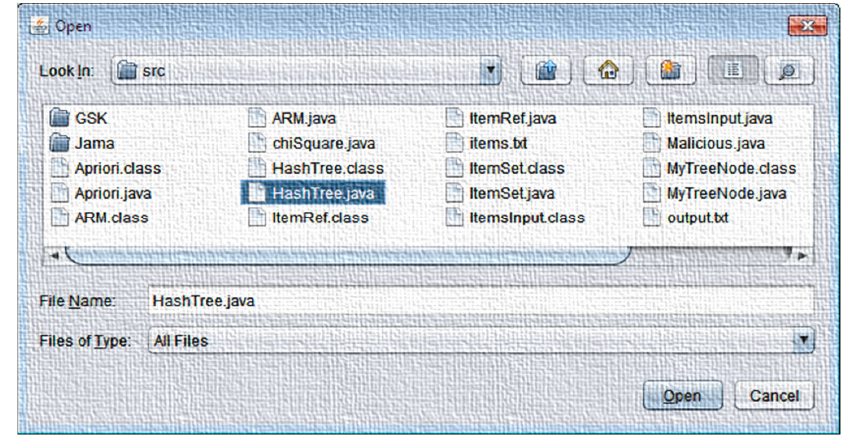
Figure 4. User selected file for reliability validation.